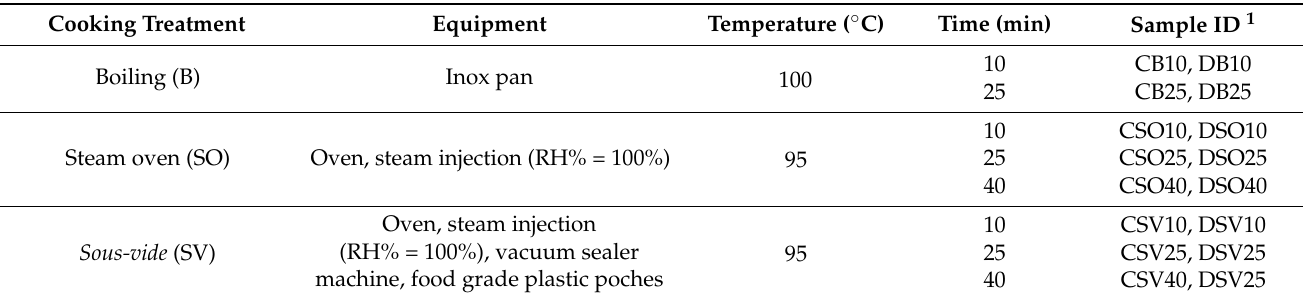
Table 1. Cooking treatment and parameters (time, temperature) applied to Cheddar (C) and Depurple (D) cauliflower